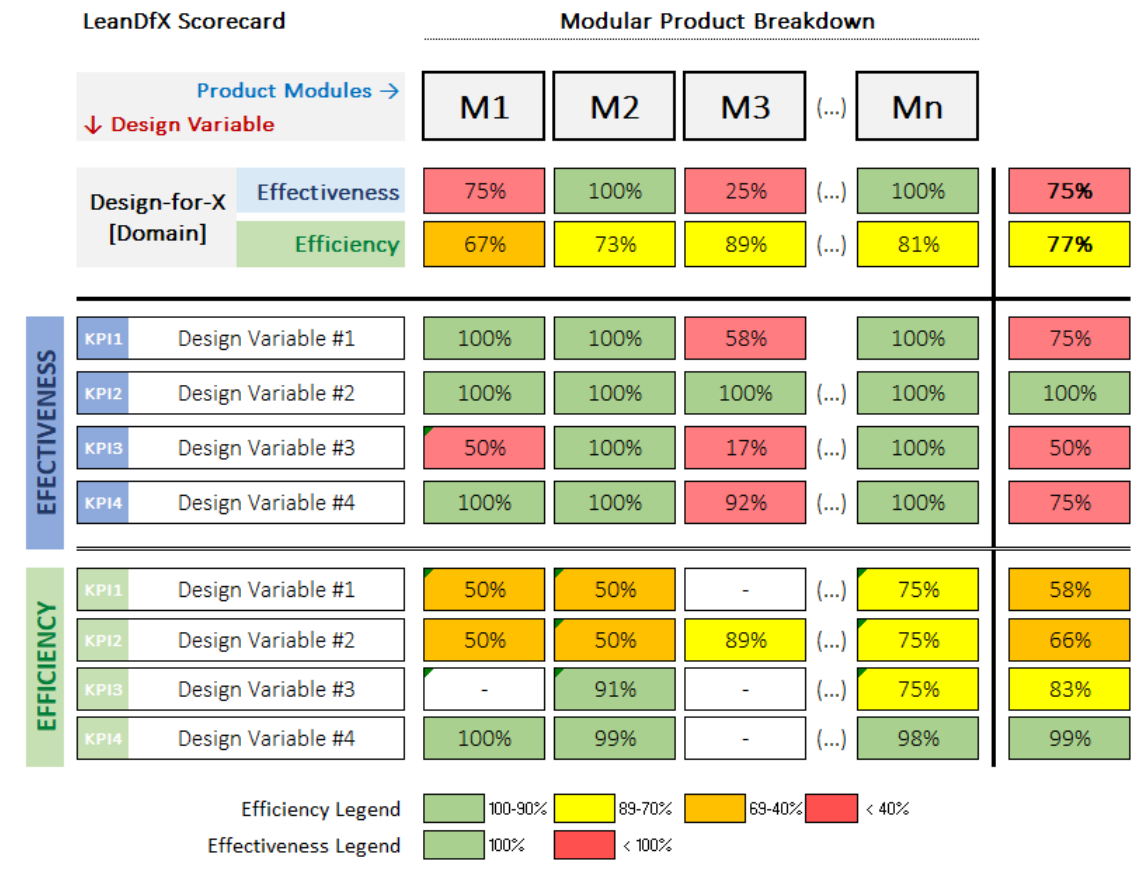
Figure 6. LeanDfX scorecard generic example. (M1, …, : modules—see Figure 5).